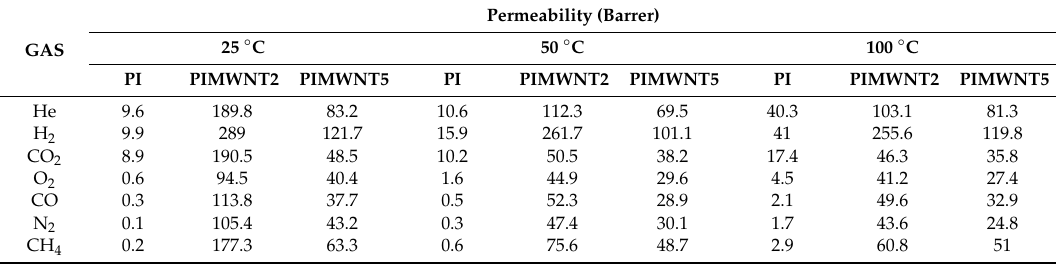
Table 5. Gas permeability values at di ff erent at di ff erent temperatures.